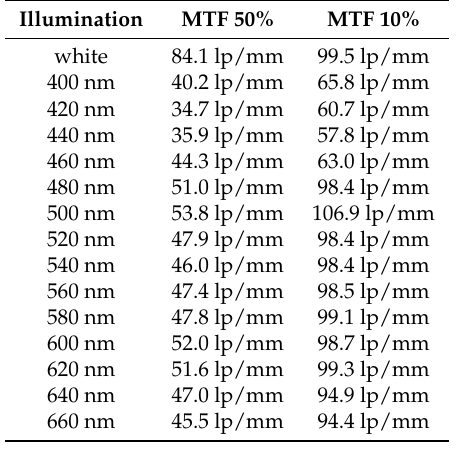
Table 2. The 50% and 10% MTF frequencies of all filters used.